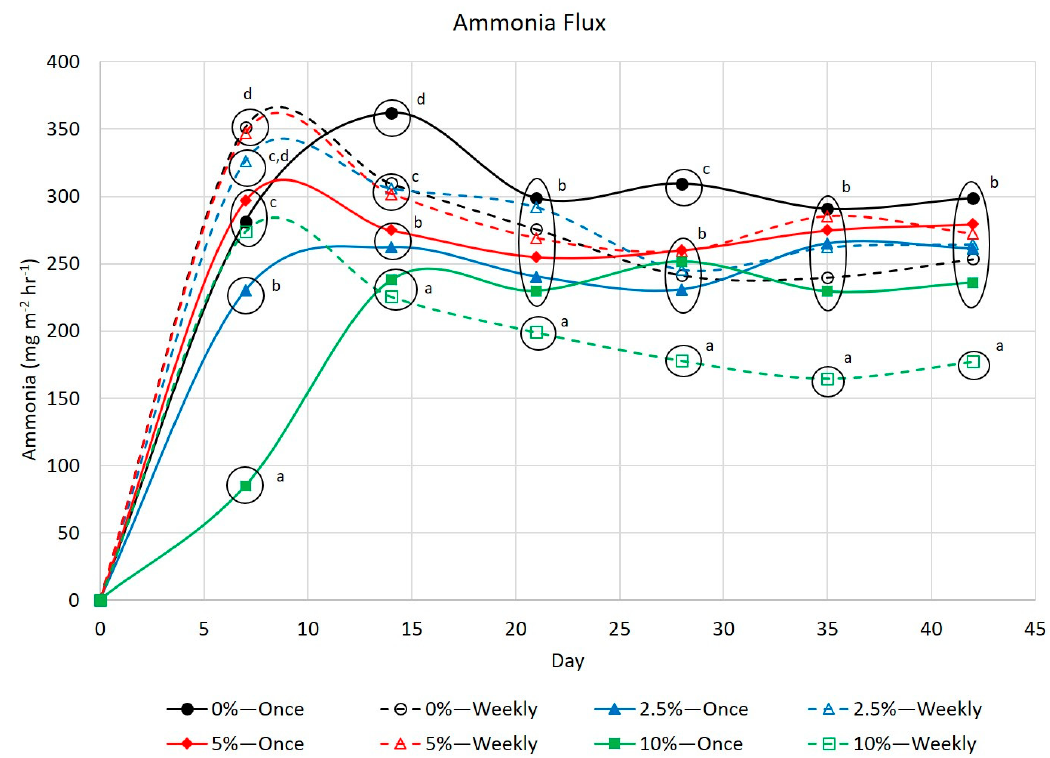
Figure 1. Average ammonia flux (mg m − 2 h − 1 ) for weekly measurements taken over 42 days for bedded packs treated with 0, 2.5, 5, and 10% alum, either in one dose or in weekly doses. Alum × Dose × Day interaction p < 0.01, Pooled standard error of the mean = 8.19. Clusters with different letters indicate significant differences p < 0.05 .